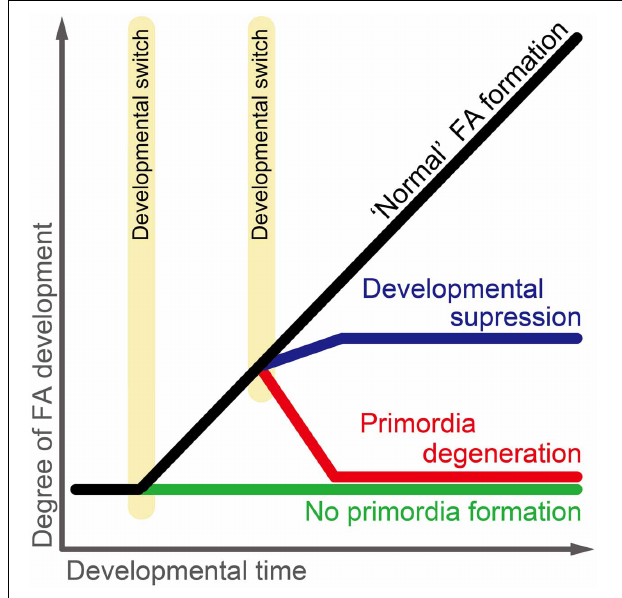
FIGURE 3 | Developmental trajectory of the flight apparatus (wings and flight muscle) in Acyrthosiphon pisum. Four developmental pathways and two developmental switches are hypothesized: the normal flight apparatus formation pathway is seen in wing and flight muscle primordia in winged males and viviparous females; the developmental suppression pathway is seen in flight muscle development of wingless males; the primordia degeneration pathway is seen in wing and flight muscle primordia development in wingless viviparous females and wing primordia development in wingless males; the no primordia formation pathway is seen in wing and flight muscle primordia development in fundatricies and oviparous females. Two developmental switches regulate primordia formation per se and the developmental fate of once-formed primordia, respectively. FA, flight